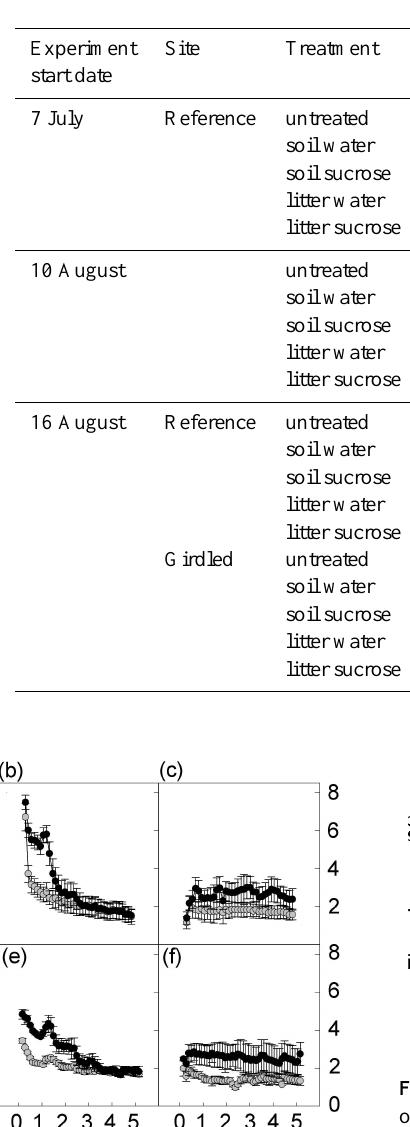
Table 1. Results of non-linear mixed effects modeling of the temporal respiration response to treatments using the following model: R = R max exp ( − kt) + γT soil + β , where R max indicates the initial respiration rate following solution applications, k indicates the decay of respiration over time, and γ is the temperature sensitivity of respiration. Bold values indicate parameters that were significantly different from the untreated (for water treatments) or water-treated (for sucrose treatments) parameters ( α = 0 . 05). P values for significance of parameters: ∗ ≤ 0 . 05; ∗∗ ≤ 0 . 01; ∗∗∗ ≤ 0 . 001.